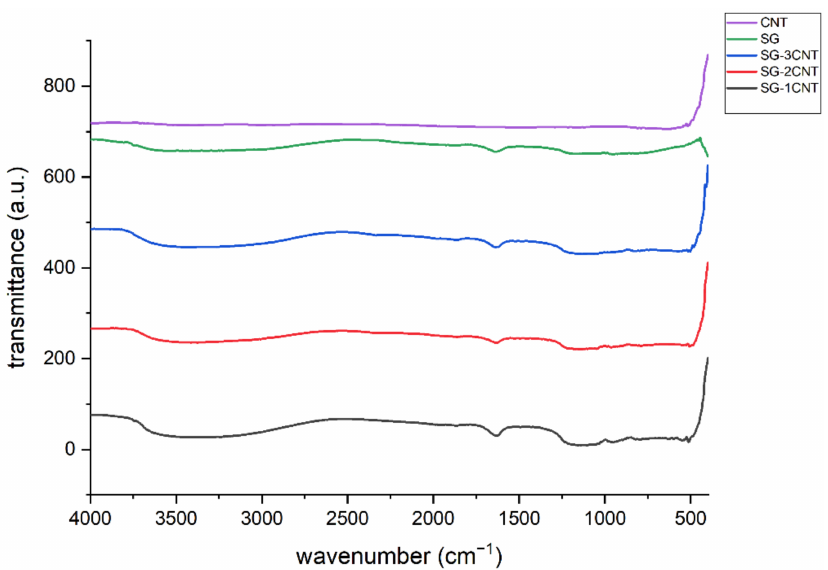
Figure 7. Results of FTIR test for MWCNTs, silica gel composites, and SG/xMWCNTs ( x = 0.25, 0.50, and 0.75 wt%).